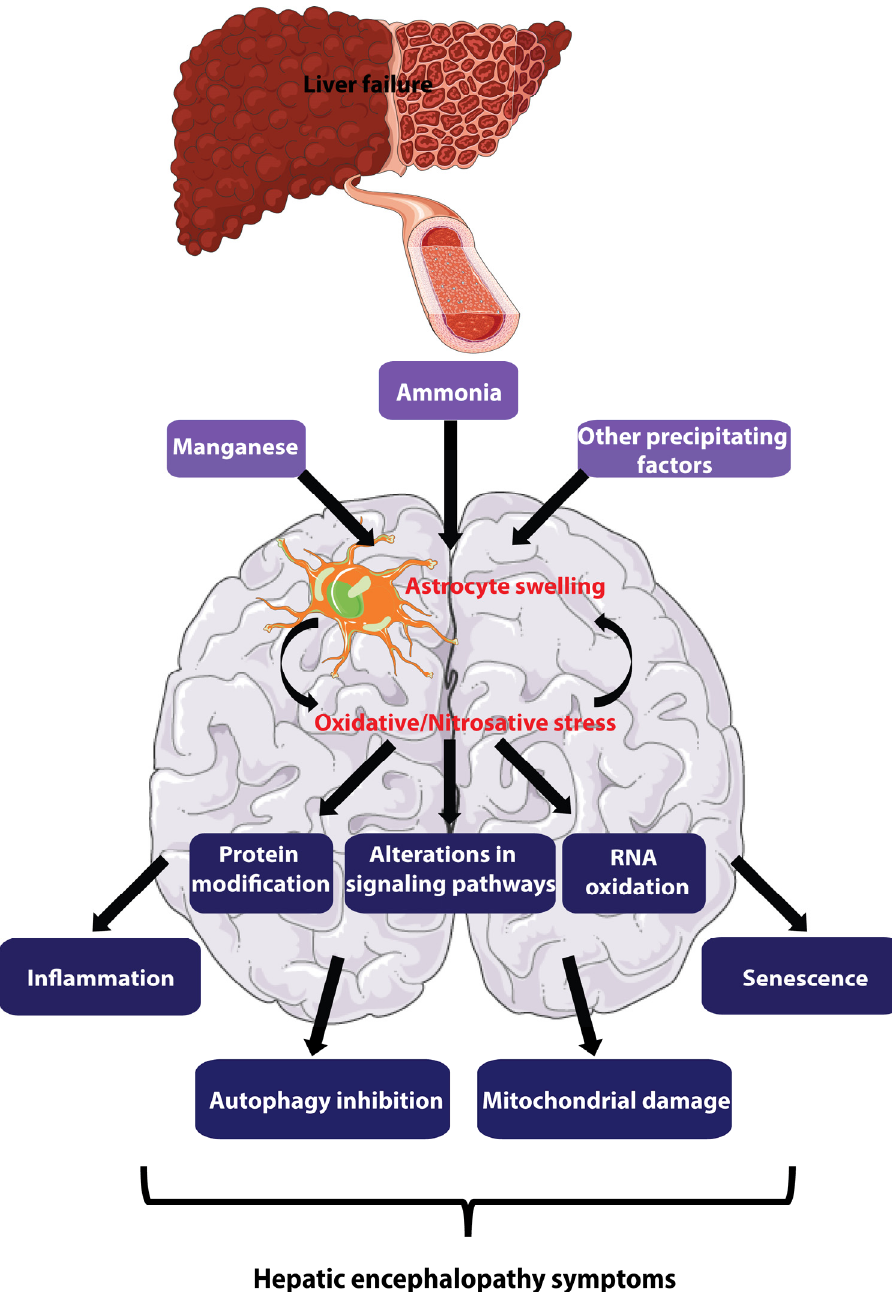
Figure 1. Major pathogenesis mechanisms of hepatic encephalopathy. Under liver dysfunction